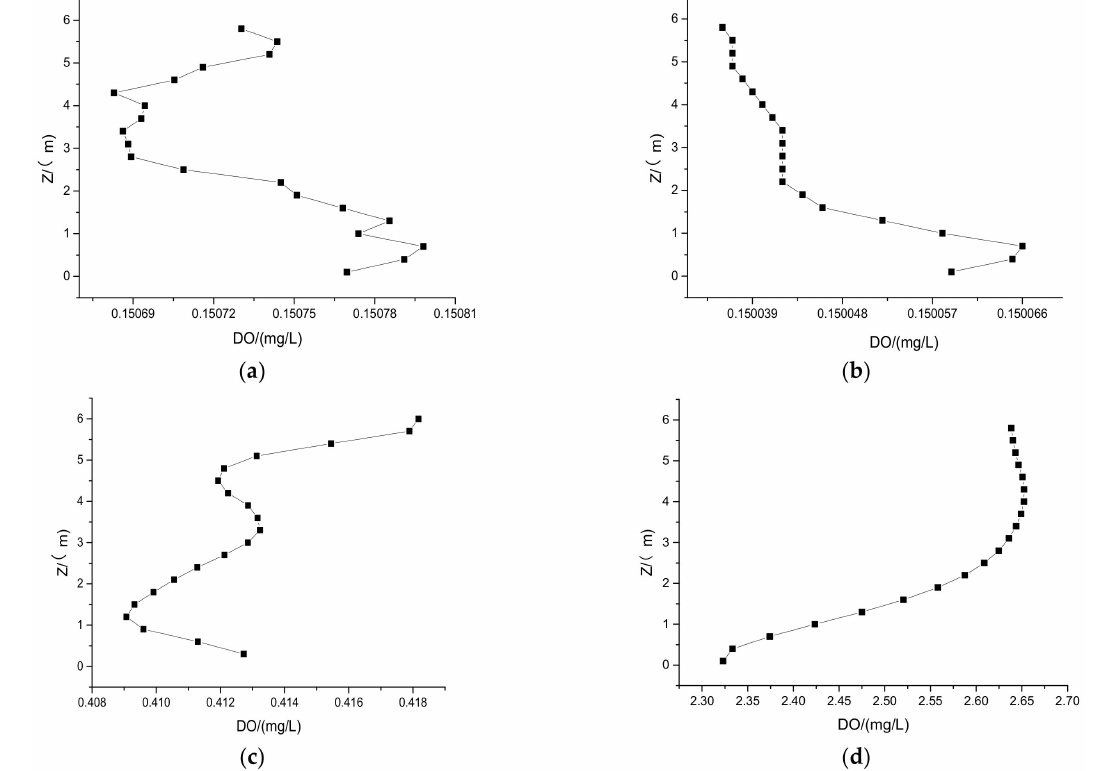
Figure 14. Curves of average DO concentration at each section. ( a ) Biological selection pool; ( b ) Anaerobic pool; ( c ) Anoxic pool; ( d ) Oxic